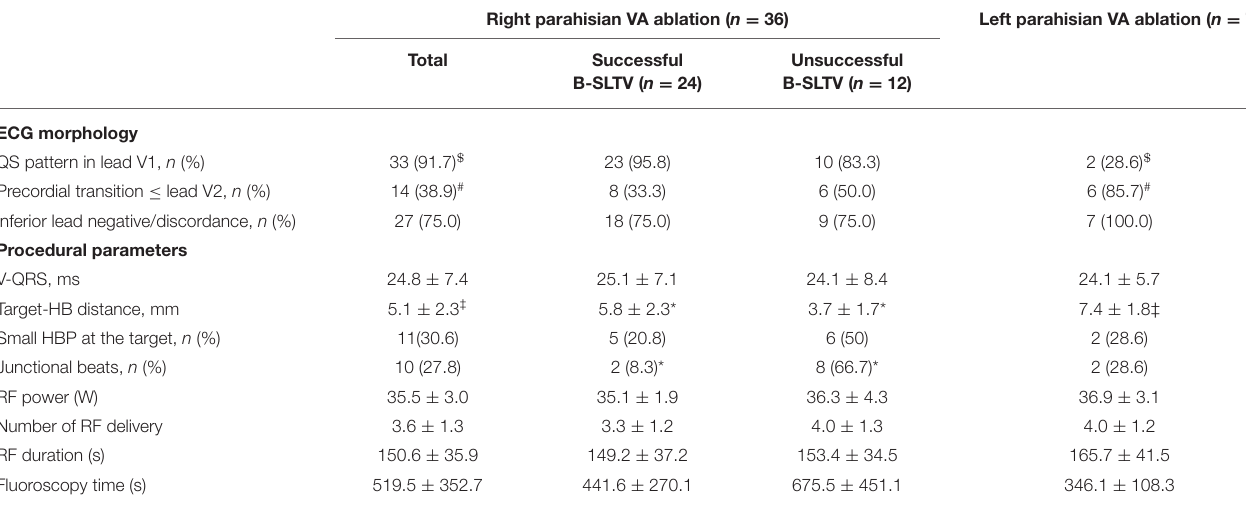
TABLE 2 | Comparison of right and left parahisian VA